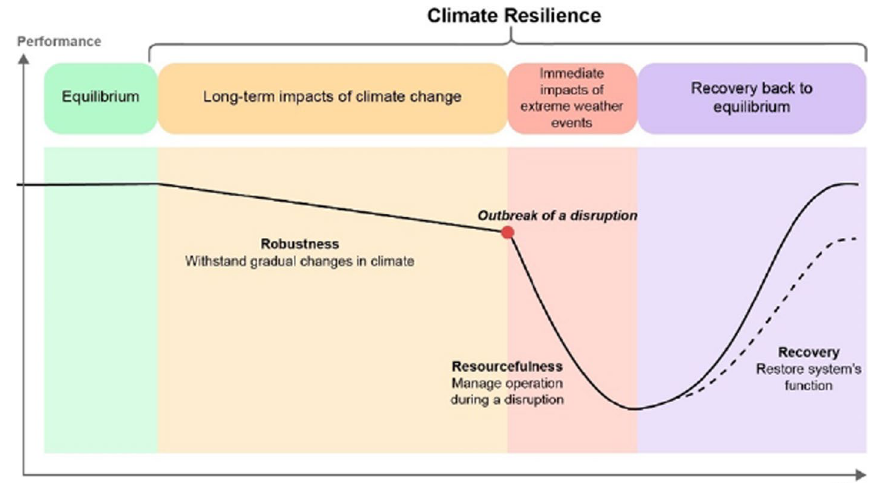
Fig. 2 The concept of climate resilience (International Energy Agency (IEA)